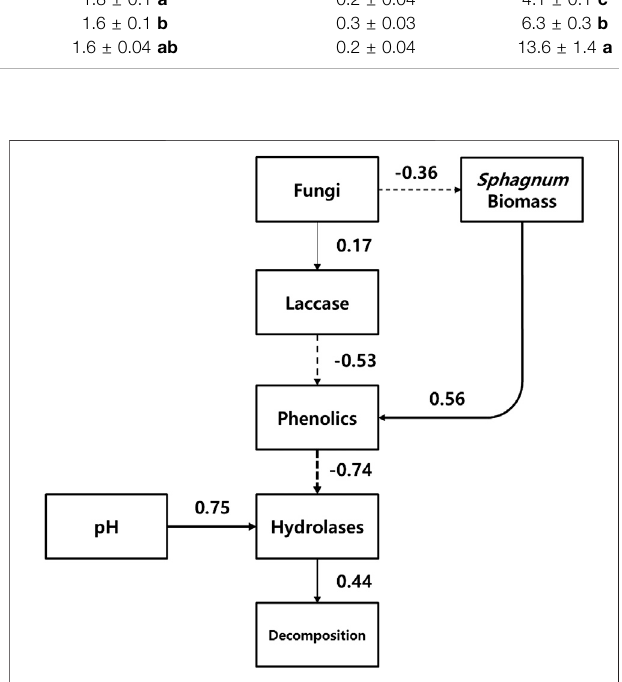
FIGURE 6 | Conceptual diagram for the water table fl uctuation-induced changes in ‘ enzymic latch ’ mechanism. Numbers denote Spearman correlation coef fi cient between the measurements, with the sign indicating positive (solid line) or negative (dotted line) effect. The width of the lines indicates the magnitude of the